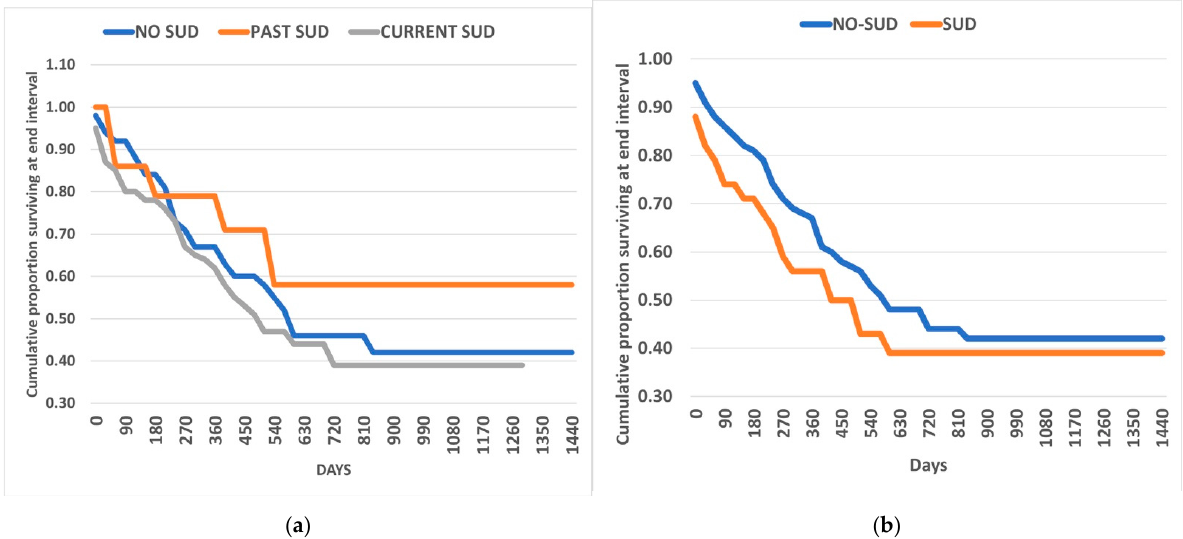
Figure 1. Retention in treatment of A-ADHD patients treated with A-ADHD medications according to Past SUD, Current SUD, and no-SUD ( a ) and with and without lifetime SUD comorbidity ( b ).